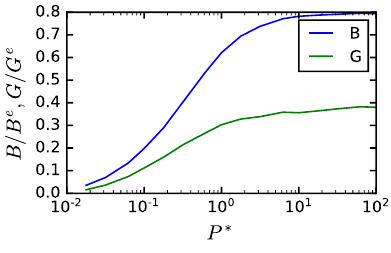
Figure 4. Normalised elastic moduli, B / B e and G / G e , versus P ⇤ , in compression of low-coordination system of Fig.